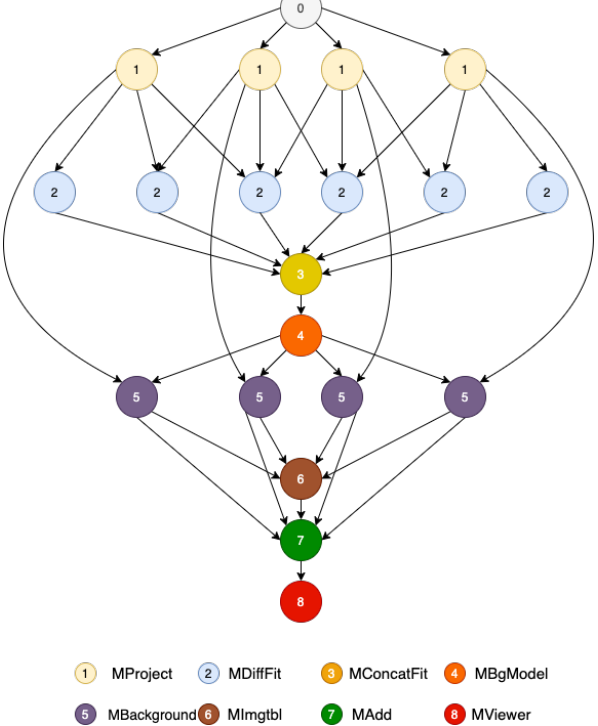
Figure 3. A Simple Montage Workflow used in this